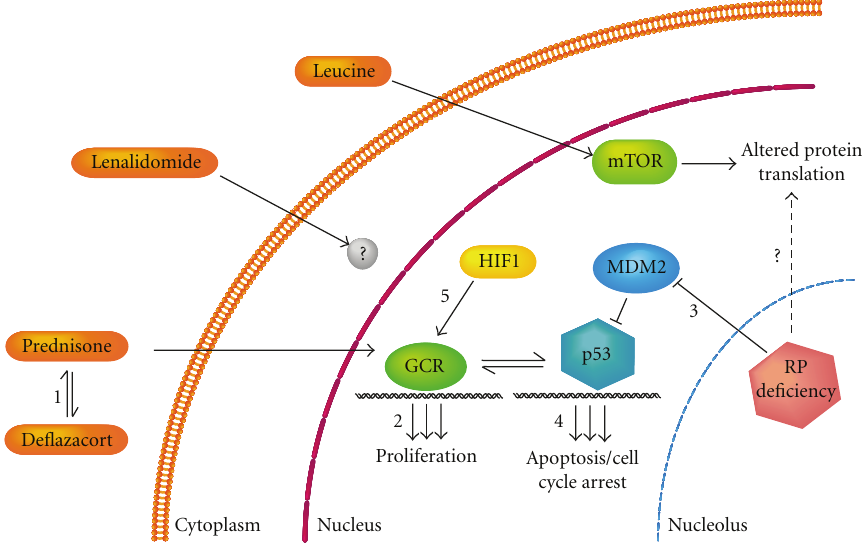
Figure 1: Pathways involved in DBA pathogenesis and possible targets for new drugs. (1) Replacement of prednisone with a GC receptor agonist with potentially less side e ff ects, for example, deflazacort. (2) Identification of genes involved in the therapeutic response to prednisone and subsequent identification of compounds that specifically induce or activate these genes. (3) Identification of genes and pathways involved in the mechanism by which ribosomal stress induces a p53 response. (4) Identification of genes that act downstream of p53 to induce the DBA phenotype. (5) Enhance the e ff ect of GC in combination with other compounds, for example, stabilizers of HIF1 α